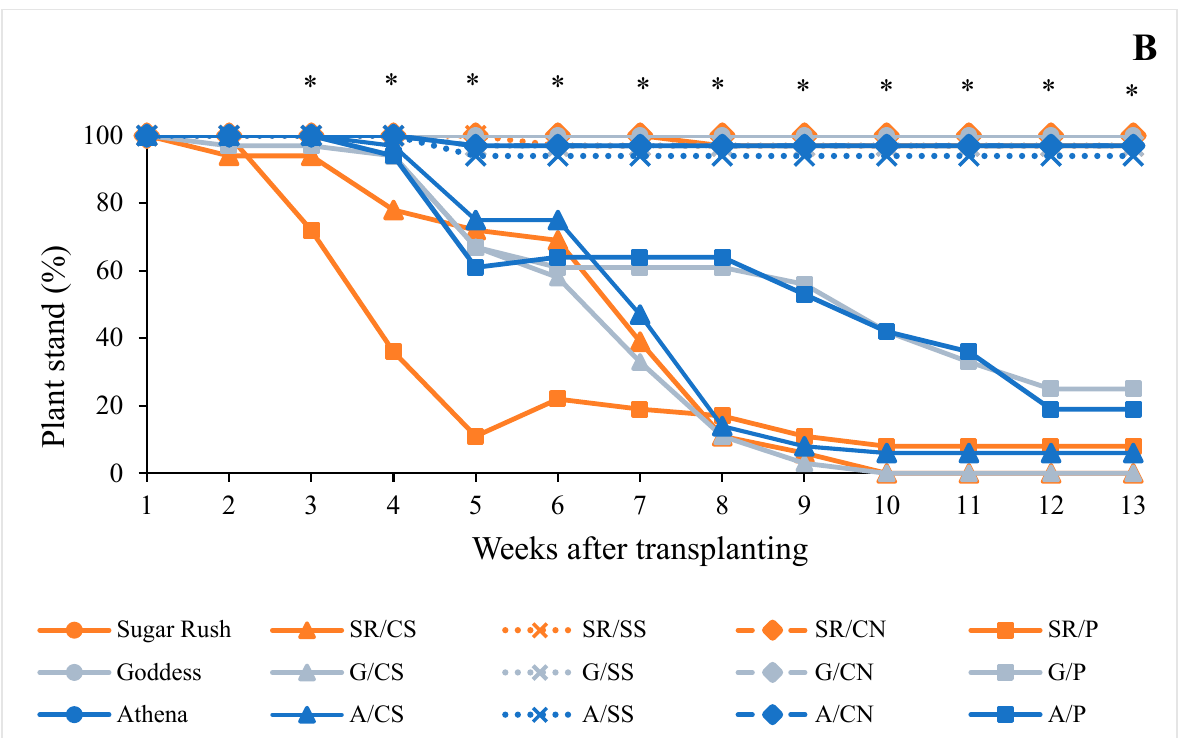
Figure 1. Plant stand of cantaloupe cultivars Sugar Rush (SR), Goddess (G) and Athena (A) nongrafted and grafted onto four rootstock cultivars Carolina Strongback (CS), Super Shintosa (SS), Carnivor (CN), and Pelop (P) grown with black soil-biodegradable plastic mulch (BDM) and measured every week from 1 June to 30 September 2020 ( A ) and 20 May to 15 August 2021 ( B ) at Mount Vernon, WA, USA. * Represent significant differences at p < 0.05.